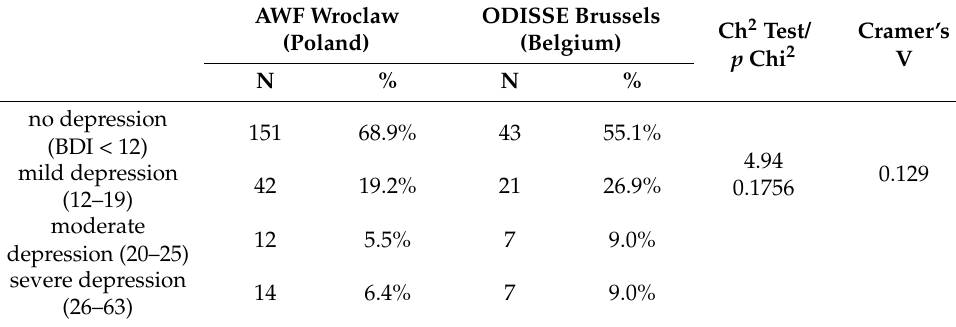
Table 5. Detailed results of the Beck Depression Inventory-summary. AWF